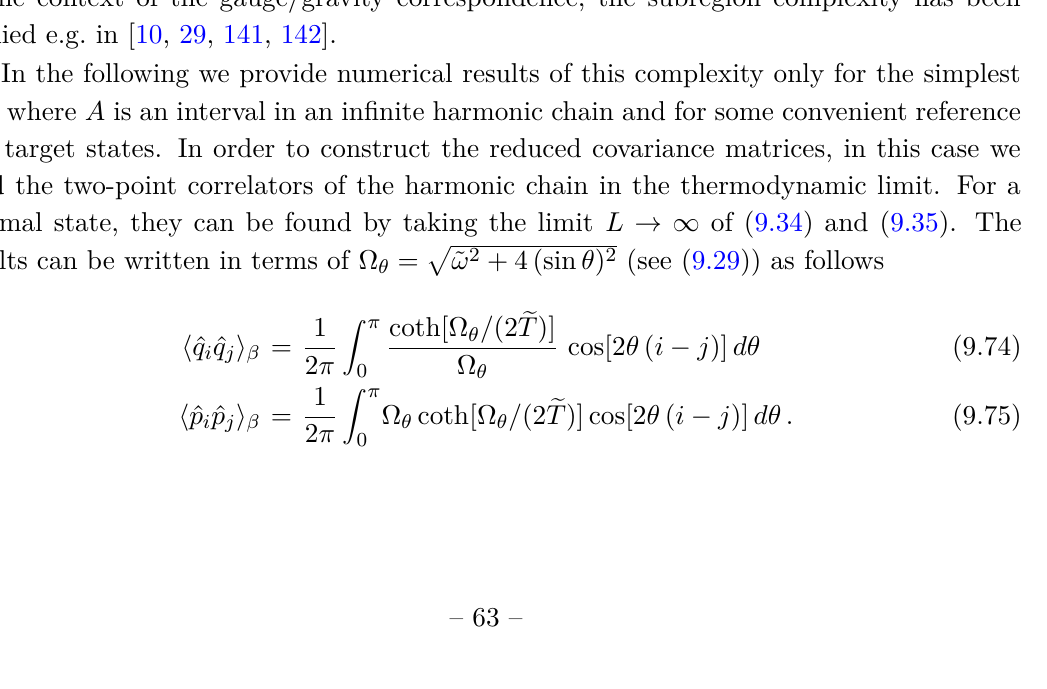
Figure 9 . Subregion complexity C 2 for an interval made by ‘ sites in an infinite harmonic chain as function of ‘ . The chain is in its ground state and ω and ˜ ω = ω . We fix ω = 1 , considering various values for ω T T R ω < ω in the right panels. The subregion complexity C 2 is reported in the top panels, while its T R subleading term is studied in the bottom